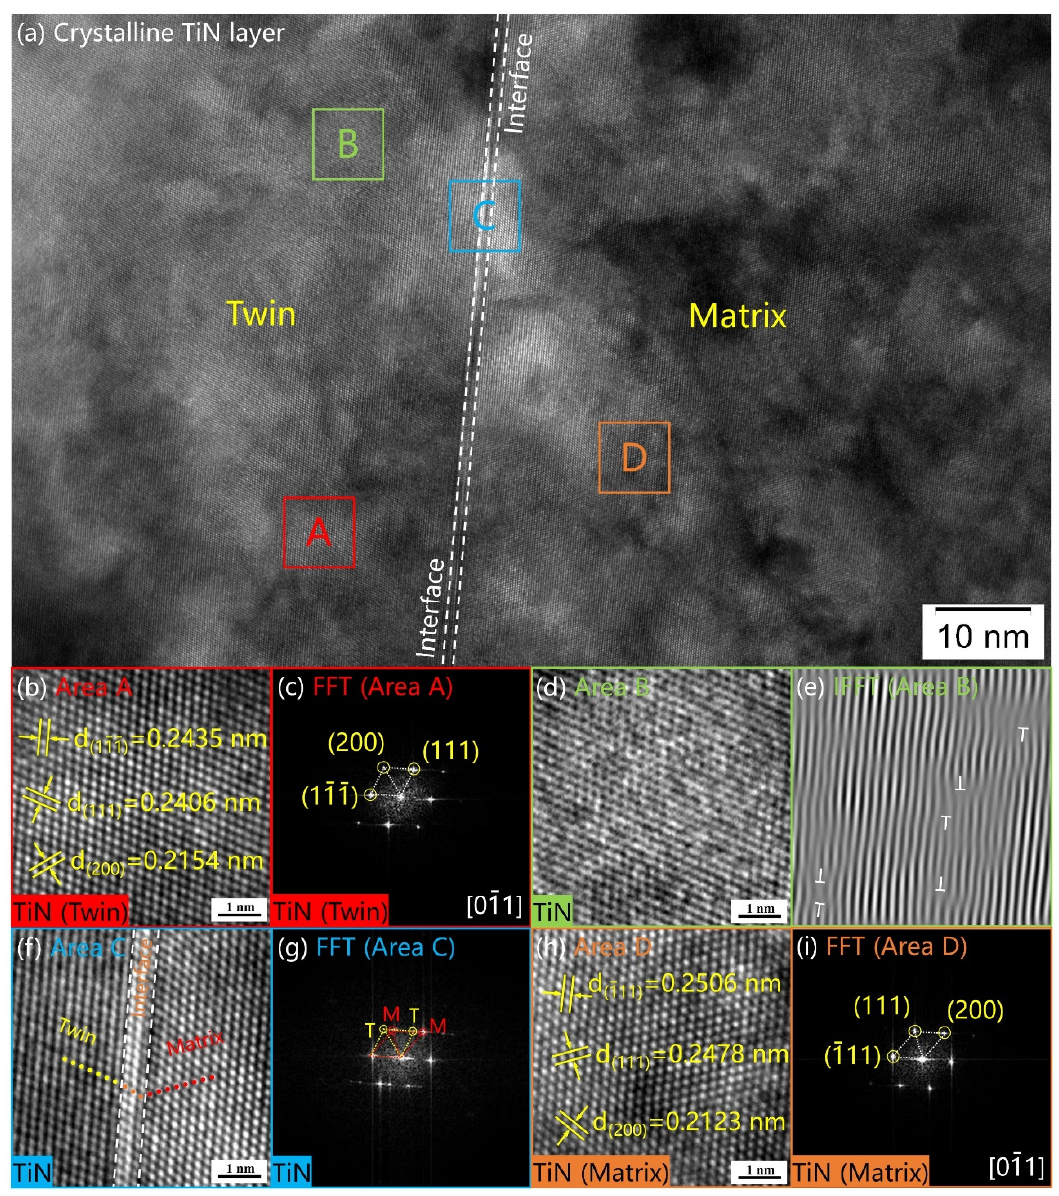
Figure 7. ( a ) The HRTEM image of crystalline TiN layer. With the interface in figure ( a ) as the boundary, the left side is the twin crystal, and the right side is the matrix; ( b ) The image of twin crystal in area A; ( c ) The FFT image of area A; ( d ) The image of area B; ( e ) The IFFT image of area B. There are a large number of dislocations distributed in area B; ( f ) The image of the interface in area C; ( g ) The FFT image of area C; ( h ) The image of the matrix in area D; ( i ) The FFT image of area D.